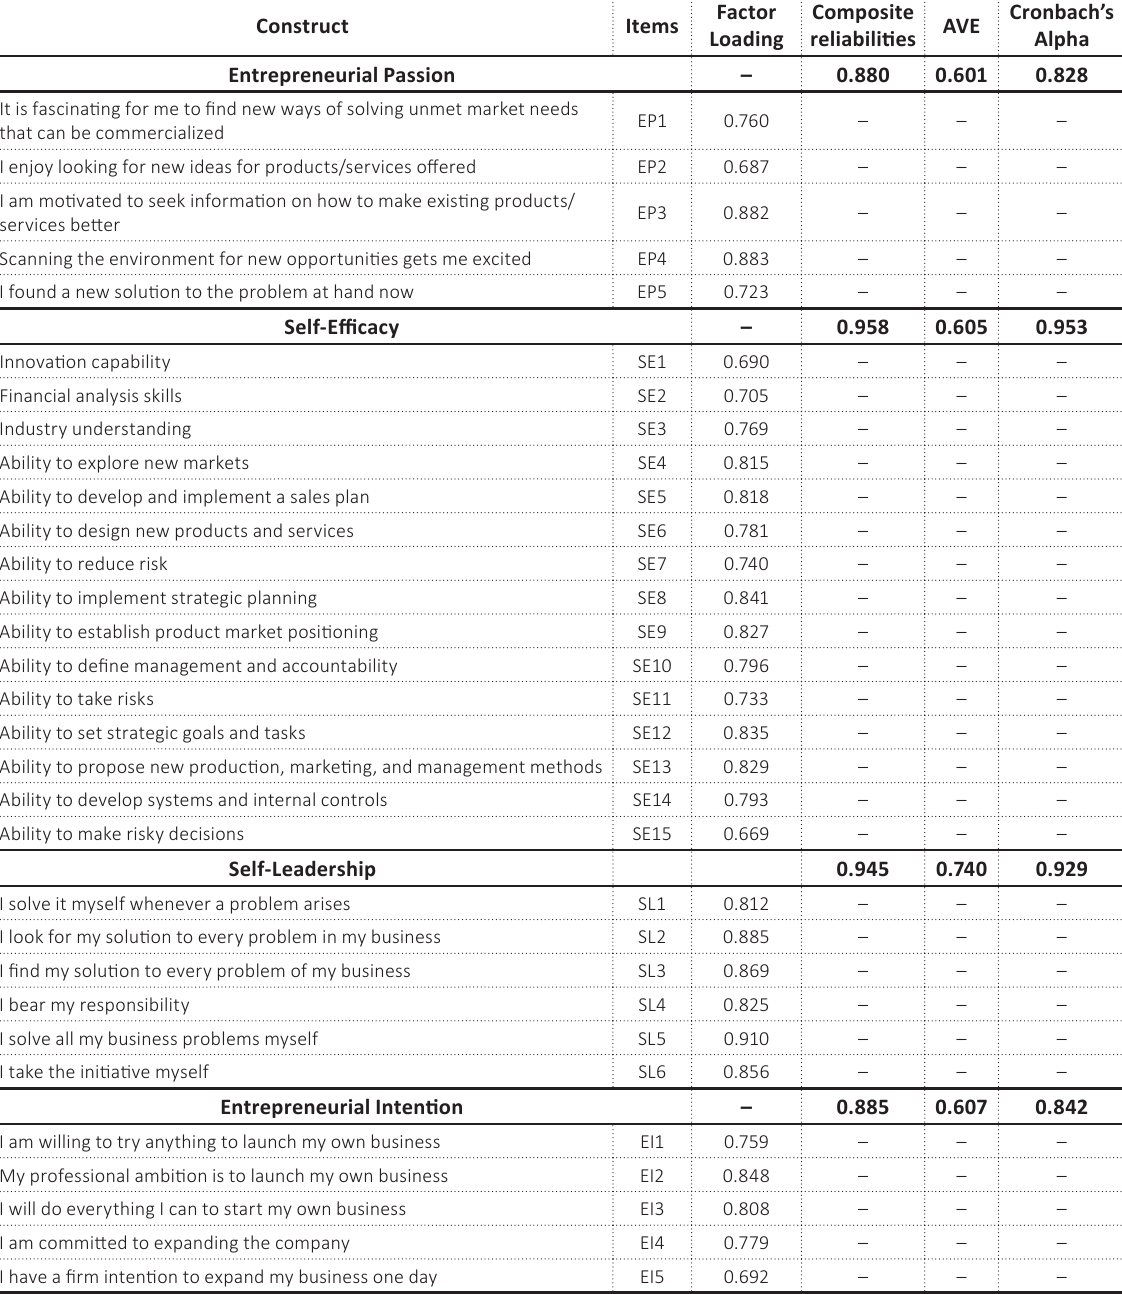
Table 2. Convergent validity testing